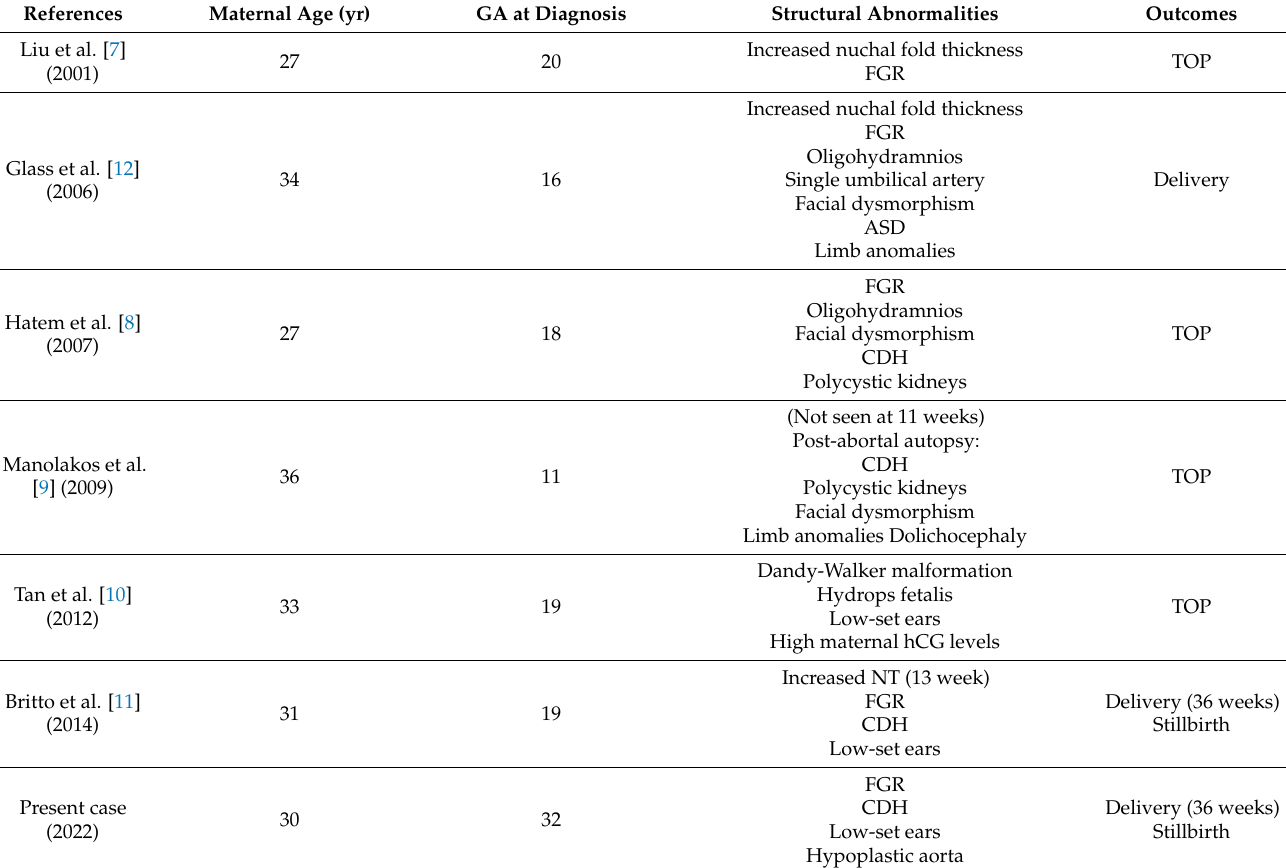
Table 1. Sonographic features of 7 fetuses with ring chromosome